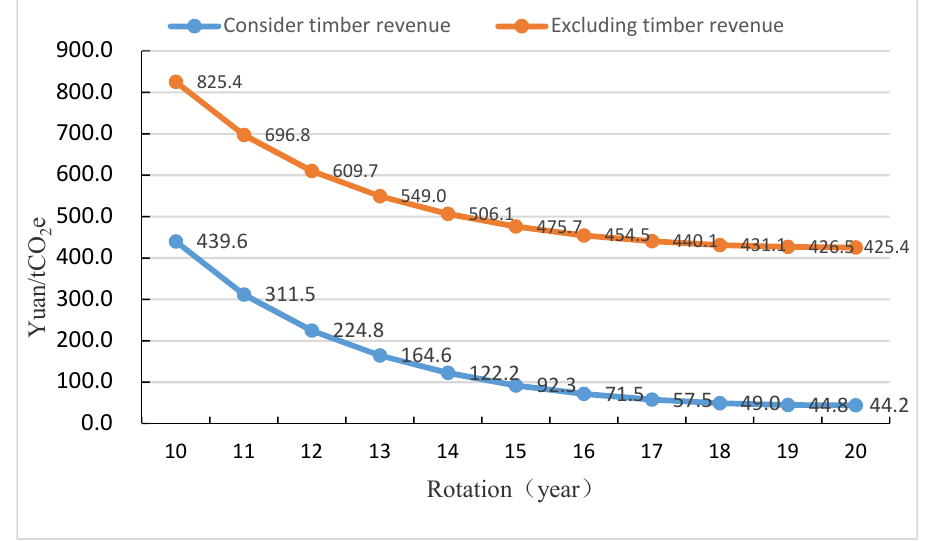
Figure 1. The carbon sink cost under different rotation periods.